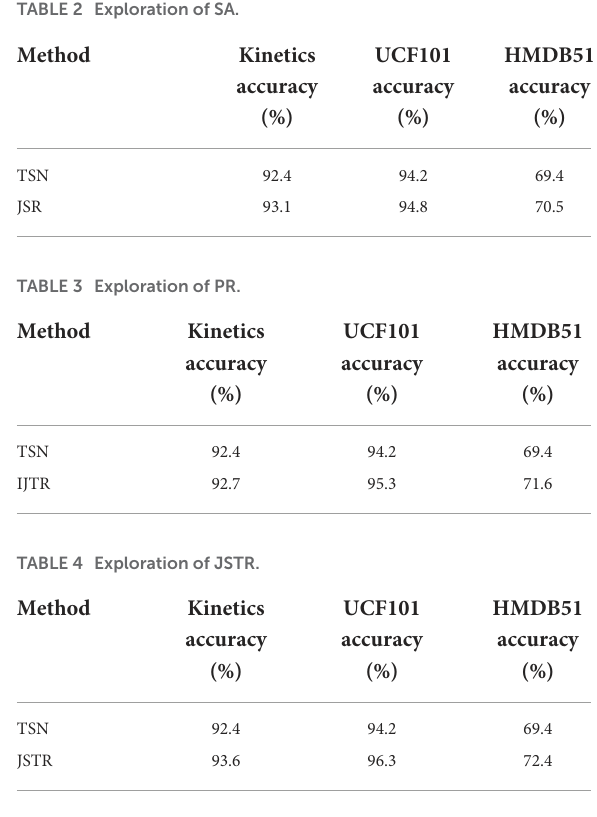
TABLE 5 Mean classification accuracy (%) compared with state-of-the-art methods on UCF101 and HMDB51.